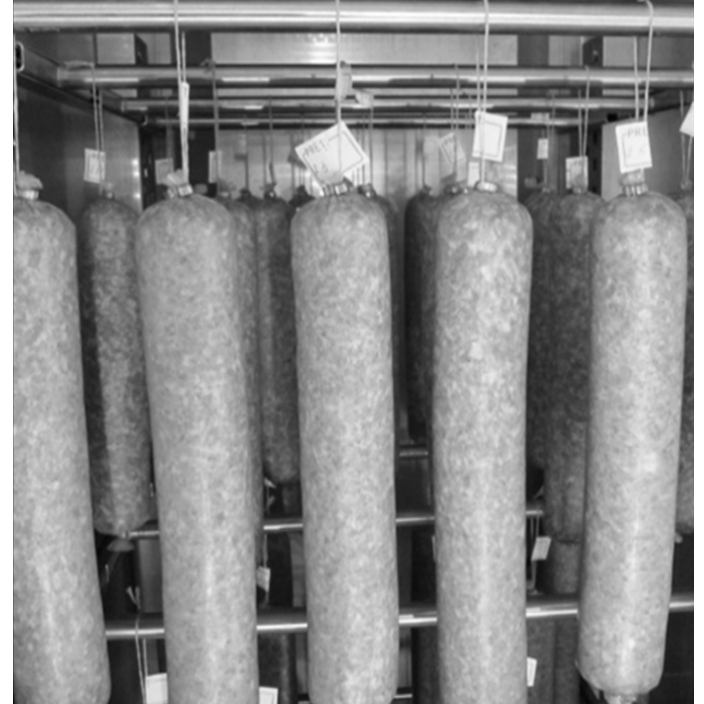
Figure 1. Initial state of salami